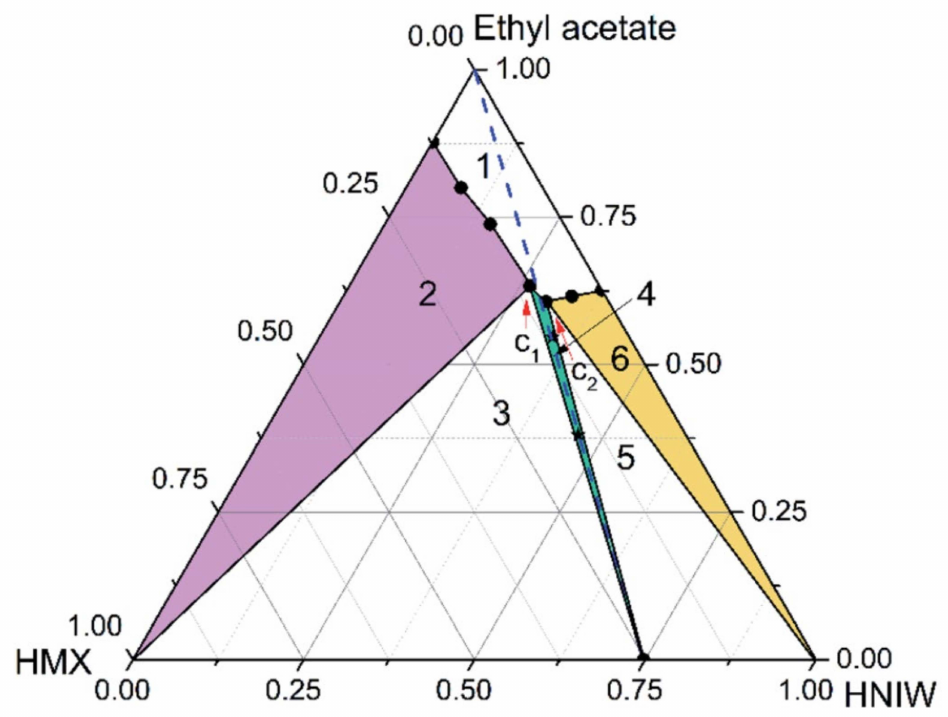
Figure 7. Ternary phase diagram for HMX–HNIW–ethyl acetate system at 15 ◦ C. The points (black stars) represent starting compositions for cocrystals. Reproduced from [106]. Copyright 2015, The Royal Society of